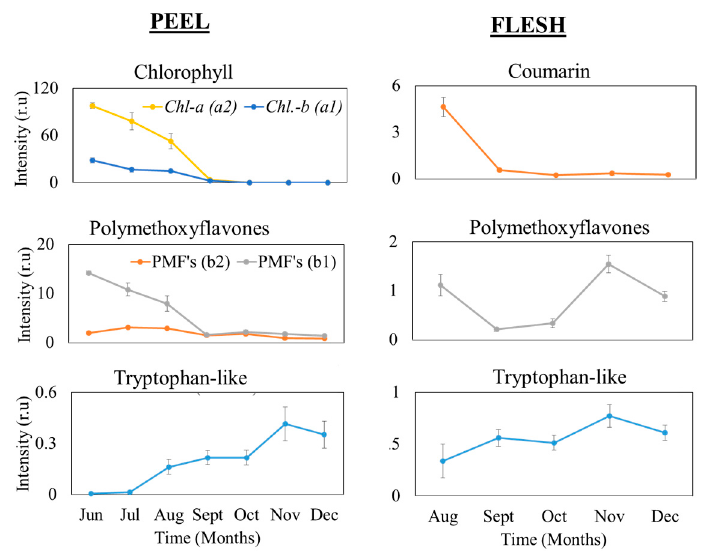
Figure 5. Fluorescence compound dynamics by time on citrus peel and flesh. Each data point is the mean ± S.D. of five replications. No coumarin was detected in the peel and no chlorophyll was detected in the flesh, so neither are shown.